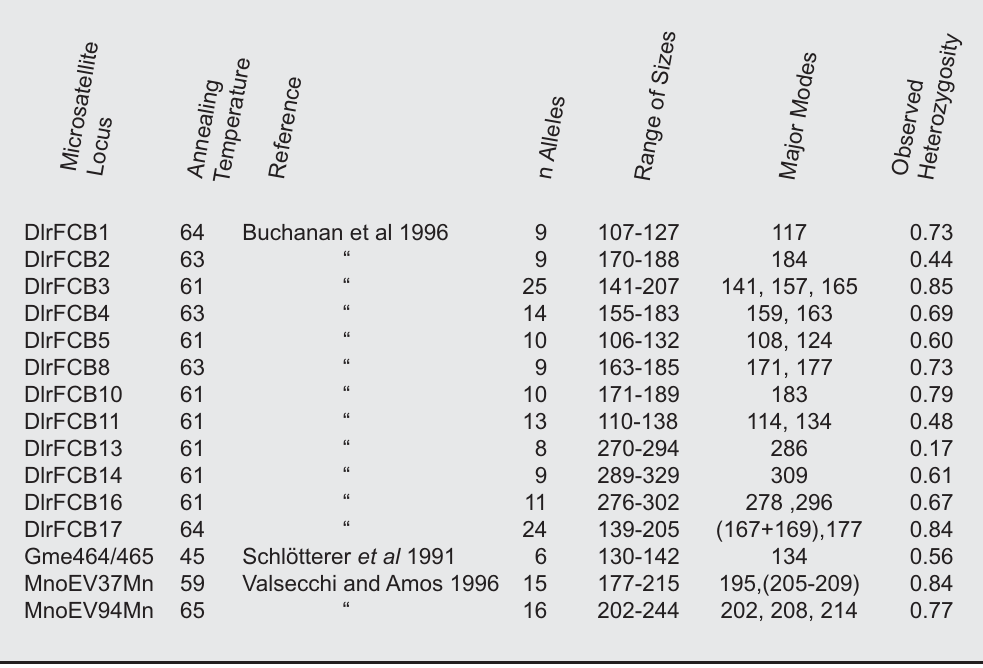
Table 2. Details of the fifteen microsatellite loci from belugas. Descriptions are based on all samples we have